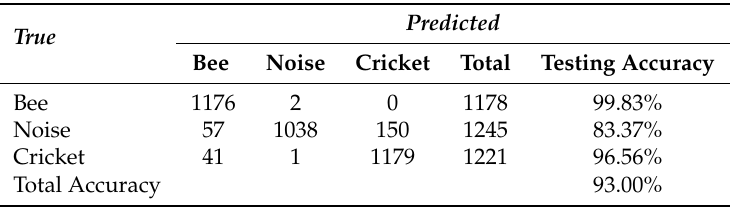
Table 7. Confusion matrix for M1 (Logistic Regression) with train/test and L2 scaling (S5) on BUZZ1 train/test dataset with 60-40 train/test